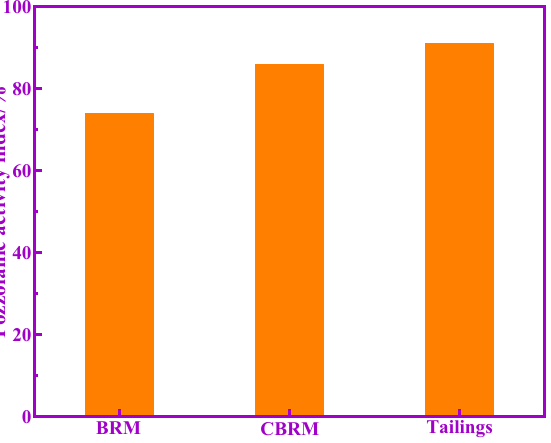
Figure 4. Pozzolanic activity index of BRM, CBRM, and Tailings.